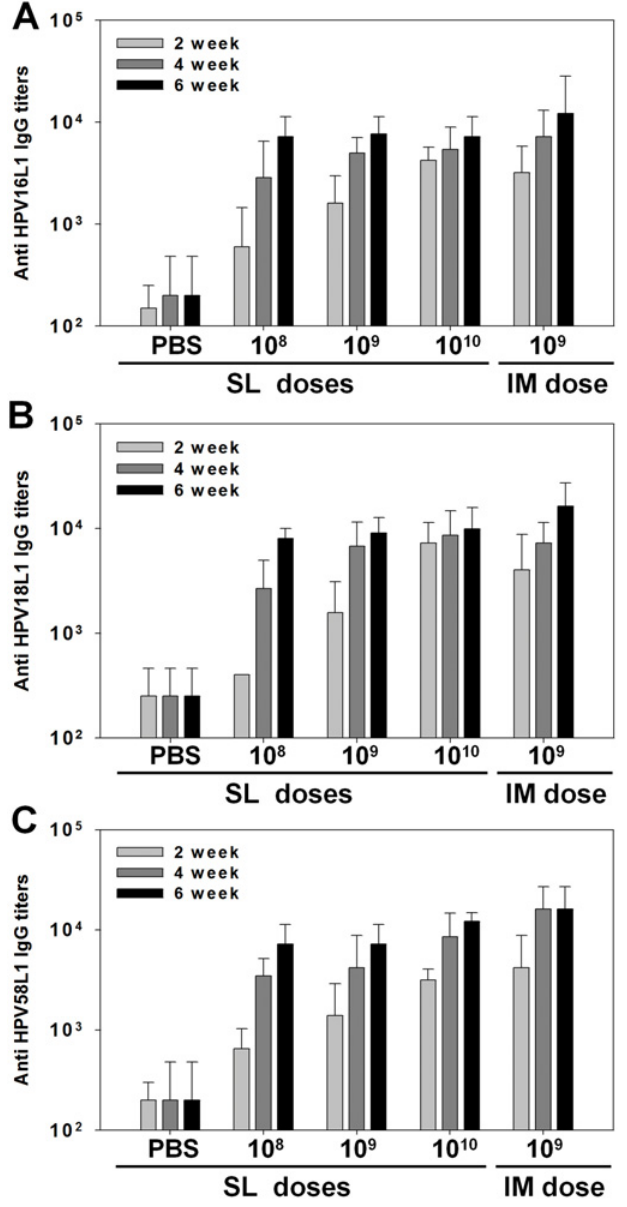
Fig 3. HPV type-specific serum IgG antibody titers after SL or IM immunization. BALB/c mice were administered AcHERV-triHPV or PBS (control) three times over a 2-week interval via the SL or IM route. Mice were sublingually immunized with three different doses of AcHERV-triHPV (1×10 8 , 1×10 9 , and 1×10 10 copies per mouse) or were immunized intramuscularly with 1×10 9 copies per mouse. Samples were collected 2, 4, and 6 weeks after the first immunization. Antigen-specific serum IgG antibody titers against HPV16L1 (A), HPV18L1 (B), and HPV58L1 (C) were determined by ELISA. * P < 0.05 compared with other groups (ANOVA and Student-Newman-Keuls test).